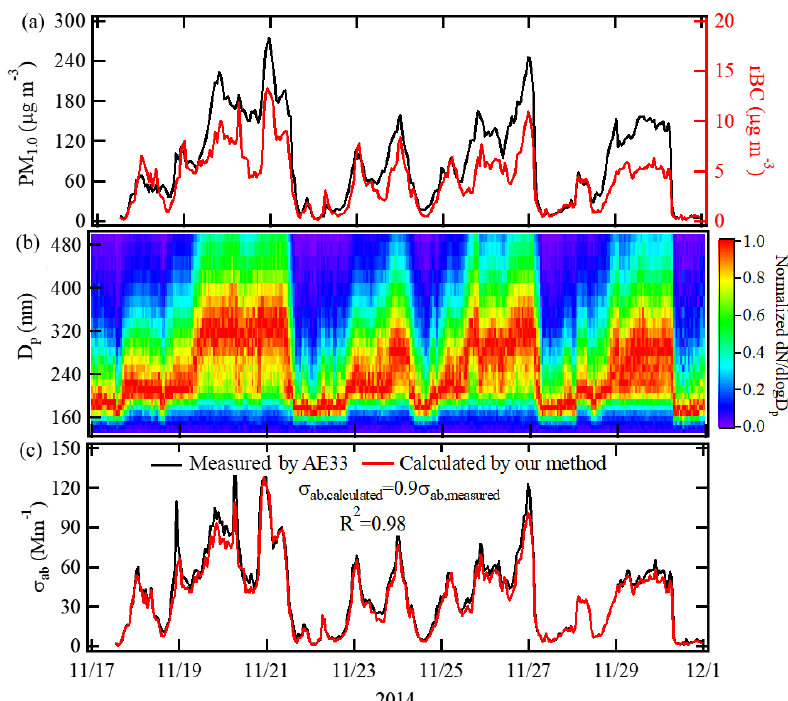
Figure 1. Time series of (a) the PM 1 and rBC mass concentrations, (b) the diameter of BC-containing particles ( D p ) , and (c) the light absorption coefficient ( σ ab ) at 880nm. The correlation between the calculated σ ab ( σ ab , calculated ) using Mie theory combined with SP2 measurements and the measured σ ab ( σ ab , measured ) from the AE33 is also shown in (c)